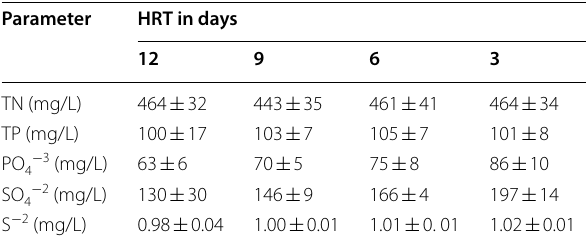
Table 5 Average TN, TP, PO methanogenesis reactor effluent at different HRT